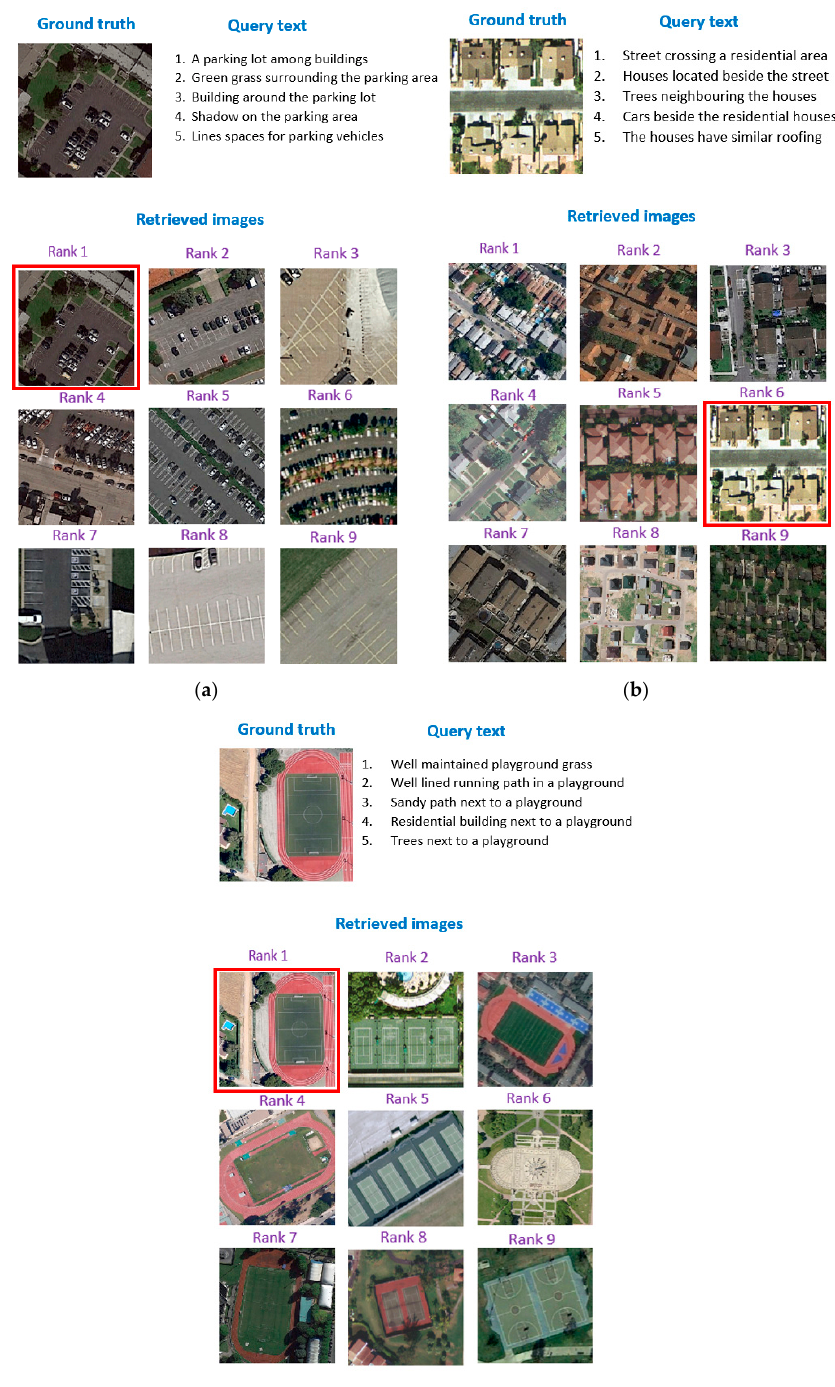
Figure 9. Successful scenarios (a, b and c) of text-to-image retrieval.